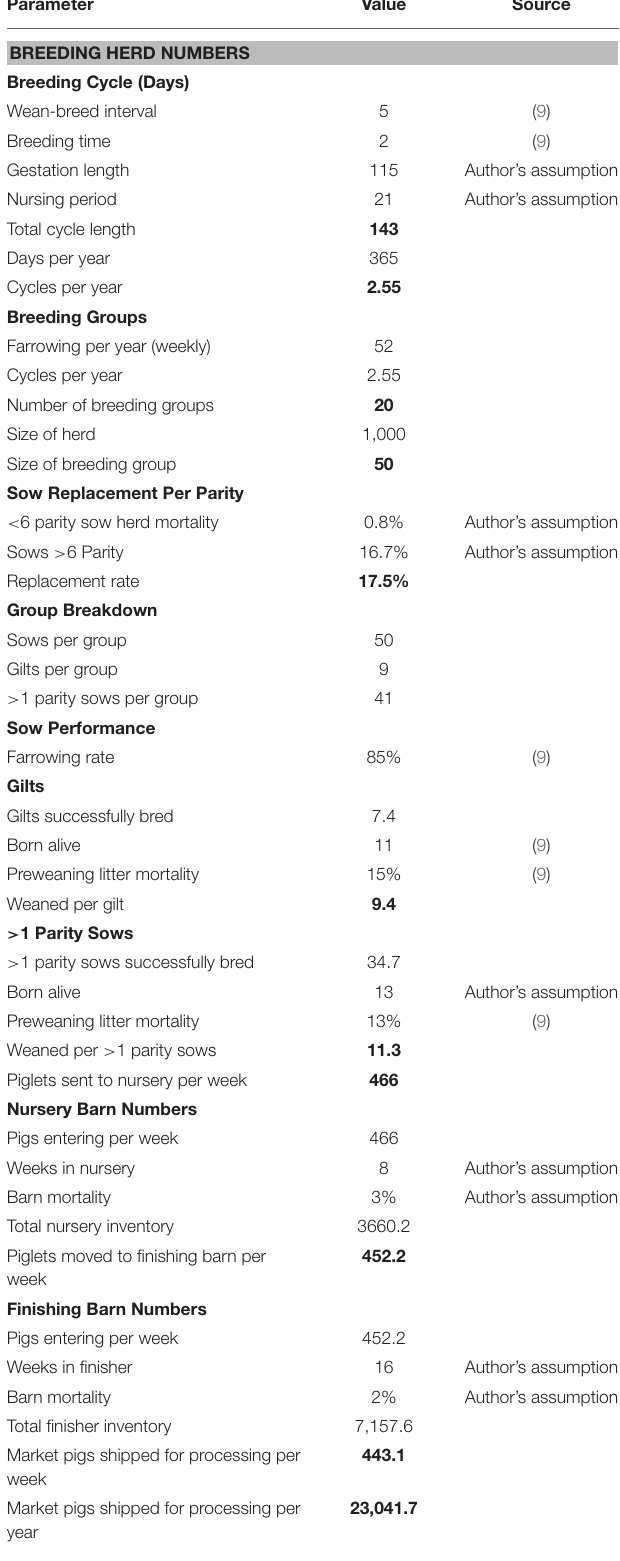
TABLE 1 | Production parameters of farrow-to-finish swine